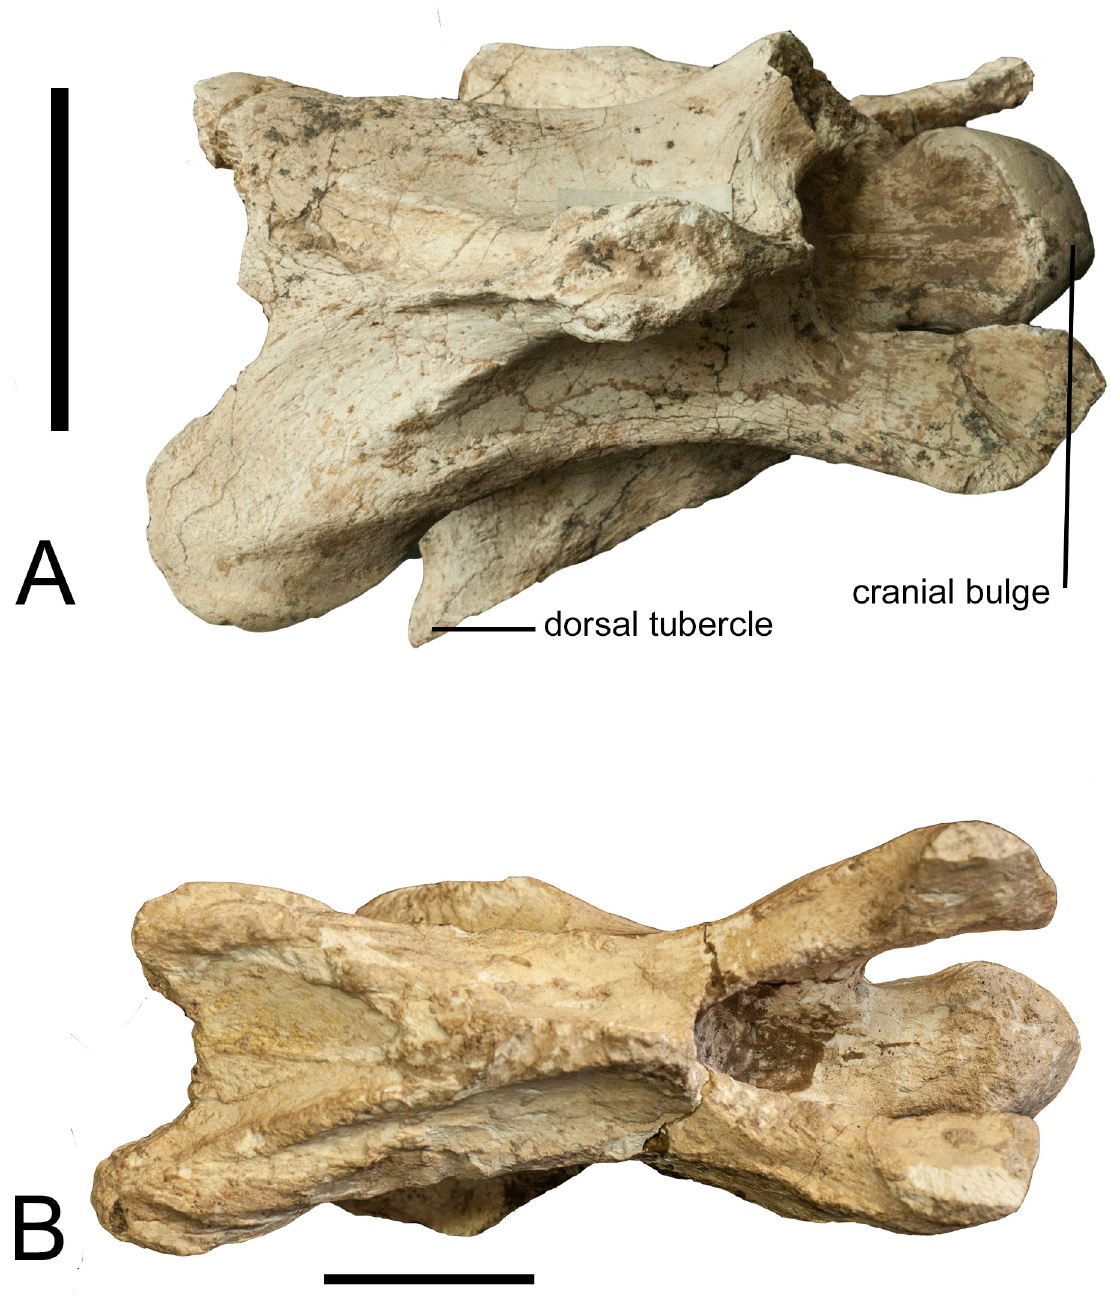
Fig 10. Comparison of cervical vertebrae. (A) Dorsal view of the third cervical vertebra of Schansitherium tafeli HMV 1988 from Gansu. (B) Dorsal view of third vertebra of Samotherium boissieri NHMUK 4250 from Samos. Scale